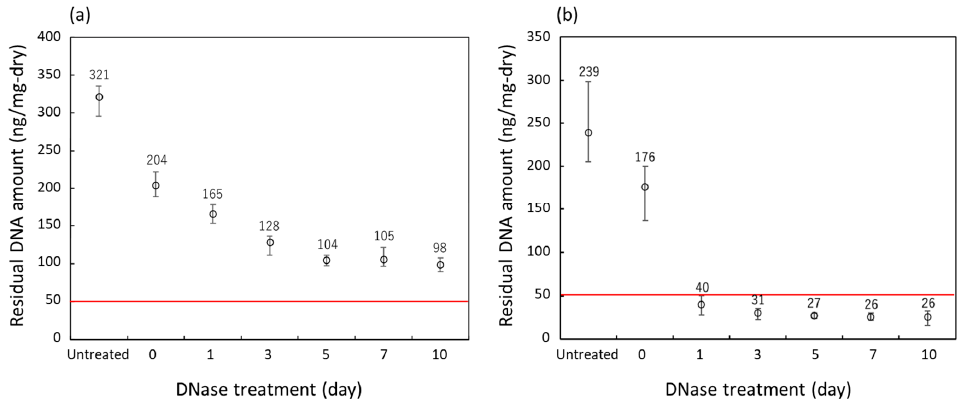
Figure 8. Residual DNA amounts in the porcine auricular cartilage upon treatment with lique fi ed DME. ( a ) 10 × 10 × 1 mm samples, ( b ) 710–1000 µm-sized samples. The DNase treatment for 0 days DME. ( a ) 10 × 10 × 1 mm samples, ( b ) 710–1000 µ m-sized samples. The DNase treatment for 0 days indicates that only lipid extraction with liquefied DME was carried out and no DNase treatment was performed. The red line indicates the regulated